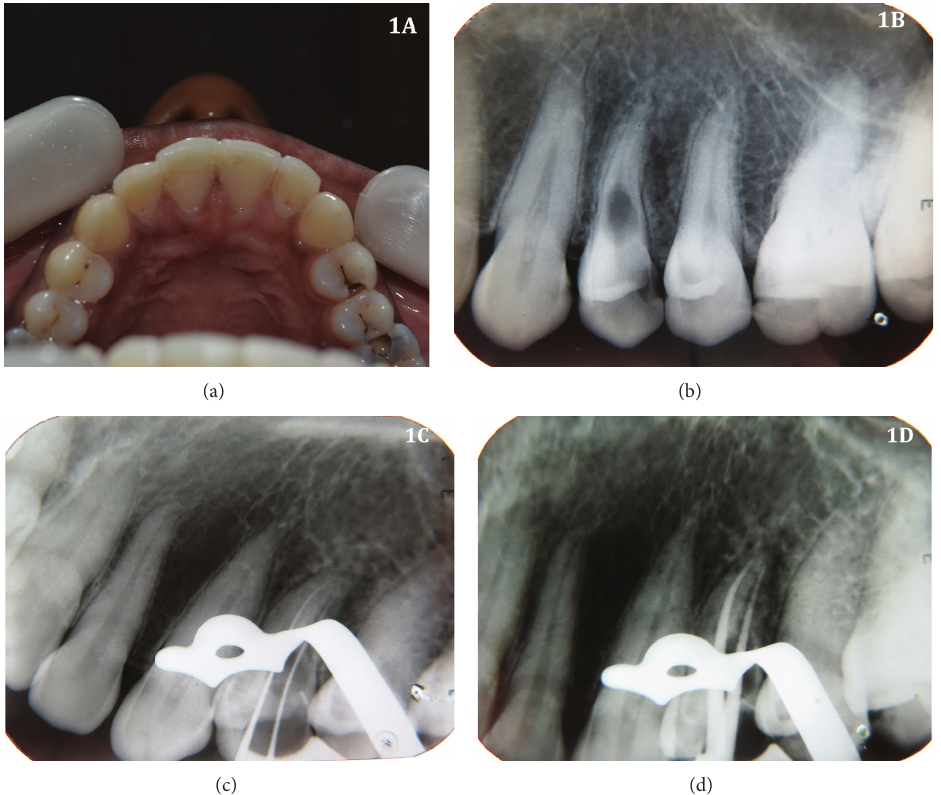
Figure 1: (a) Clinical photograph of maxillary arch occlusal view. (b) Preoperative radiograph. (c) Working length determination radiograph. (d) Master cone selection